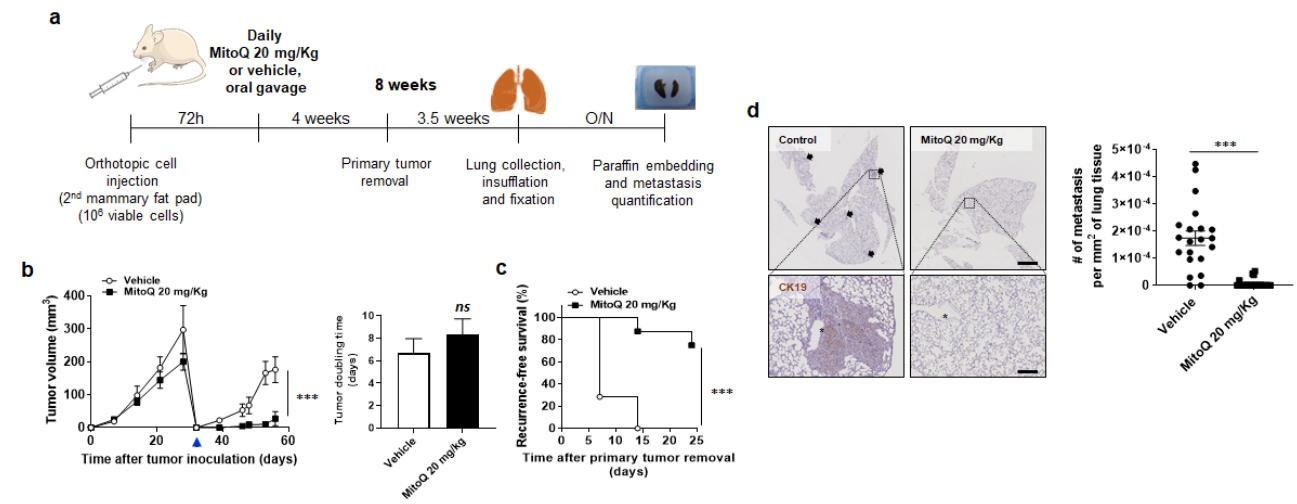
Figure 3. MitoQ prevents primary tumor recurrence and the metastatic dissemination of orthotopic triple-negative human MDA-MB-231 breast cancer in mice. ( a ) Experimental protocol for spontaneous MDA-MB-231 metastasis after orthotopic injection in the mammary fat pad of female NMRI nude mice. ( b ) On the left, primary tumor growth in mice using the protocol depicted in a ( n = 10 per group until the day of surgery; n = 7 in the vehicle-treated group and n = 8 in the MitoQ-treated group after surgery). The blue arrow indicates the day of primary tumor resection. On the right, primary tumor doubling times from 100 to 200 mm 3 before surgery ( n = 10 per group). ( c ) Kaplan-Meier graph showing recurrence-free mouse survival after surgery. Data are expressed as percentage of mice per treatment group ( n = 7 for vehicle and n = 8 for MitoQ). ( d ) At the end of the protocol shown in a, mouse lungs were removed, sliced, stained for cytokeratin 19 (CK19), counterstained with hematoxylin, and analyzed for the presence of metastases. Representative pictures are on the left at two different magnifications (bars = 16 mm for the two pictures on the top and 1 mm for the two pictures on the bottom), and metastasis quantification is on the right. All data are shown as means ± SEM. *** p < 0.001, ns : p > 0.05 compared to vehicle; by 2-way ANOVA ( b left), Student t test ( b right), Log-Rank (Mantel-Cox) test ( c ), or Mann-Whitney test ( d ).